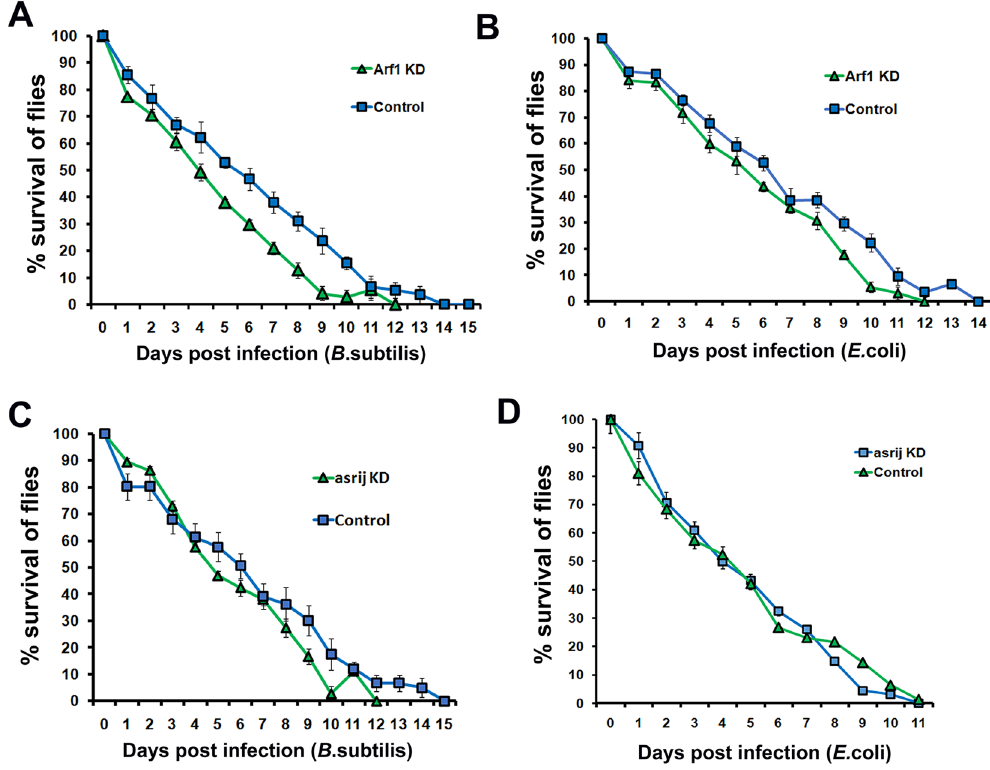
Figure 5. ARF1 and Asrij knockdown flies show compromised survival upon infection. ( A – D ) Survival curves showing that e33cGal4 -mediated ARF1 or asrij knockdown flies show a reduced survival ability as compared to its control upon infection with either B . subtilis ( A , C ) or E. coli ( B , D ). At least 100 flies were tested per genotype over at least three independent